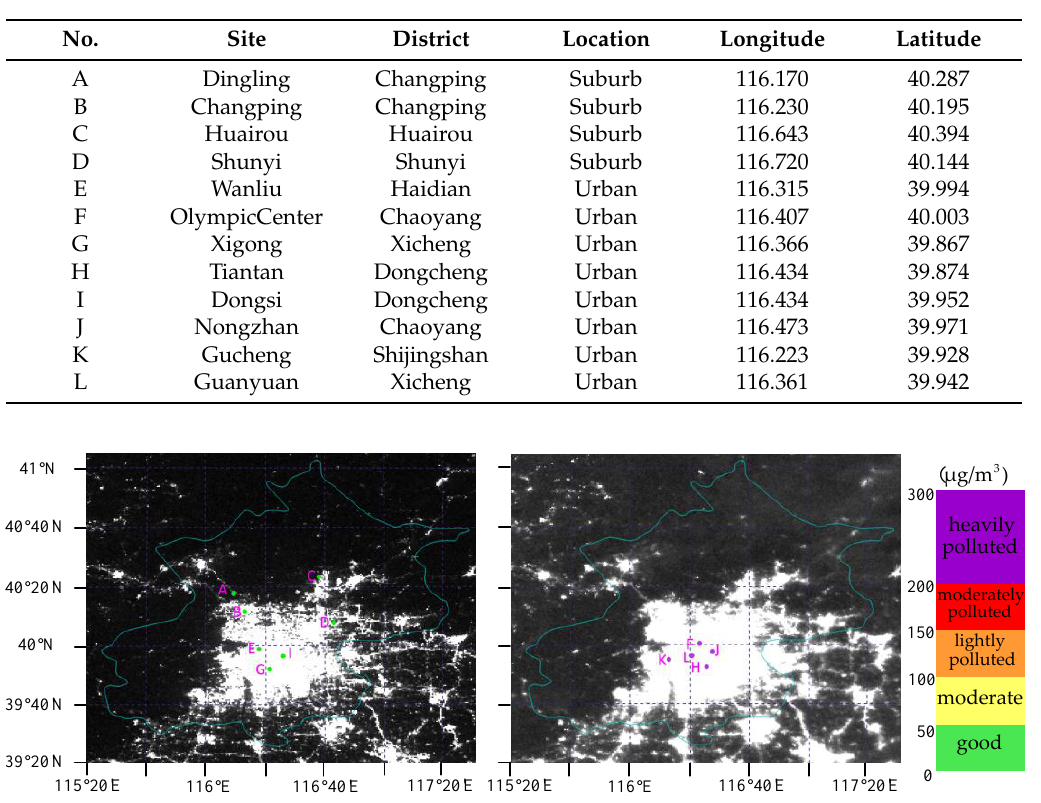
Table 1. Summary information of the 12 Beijing PM 2.5 sites.